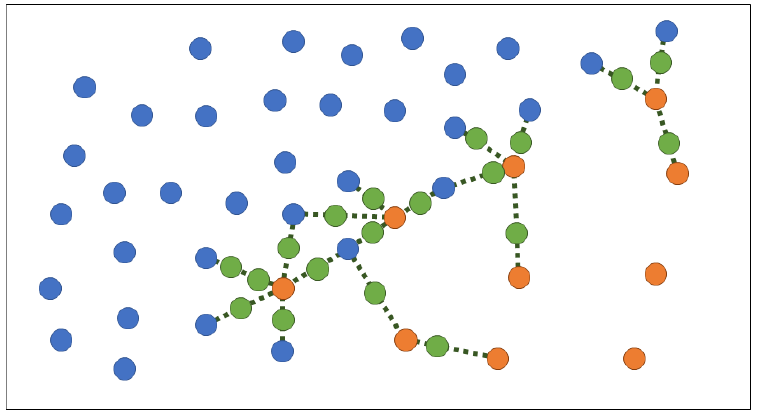
Figure 7. ADASYN processing. Blue indicates the majority dataset (non-respiratory failure). Orange indicates the minority dataset (respiratory failure). Green indicates the minority dataset (respiratory failure) generated by ADASYN. When there are more majority data surrounding minority data, more minority data are produced.